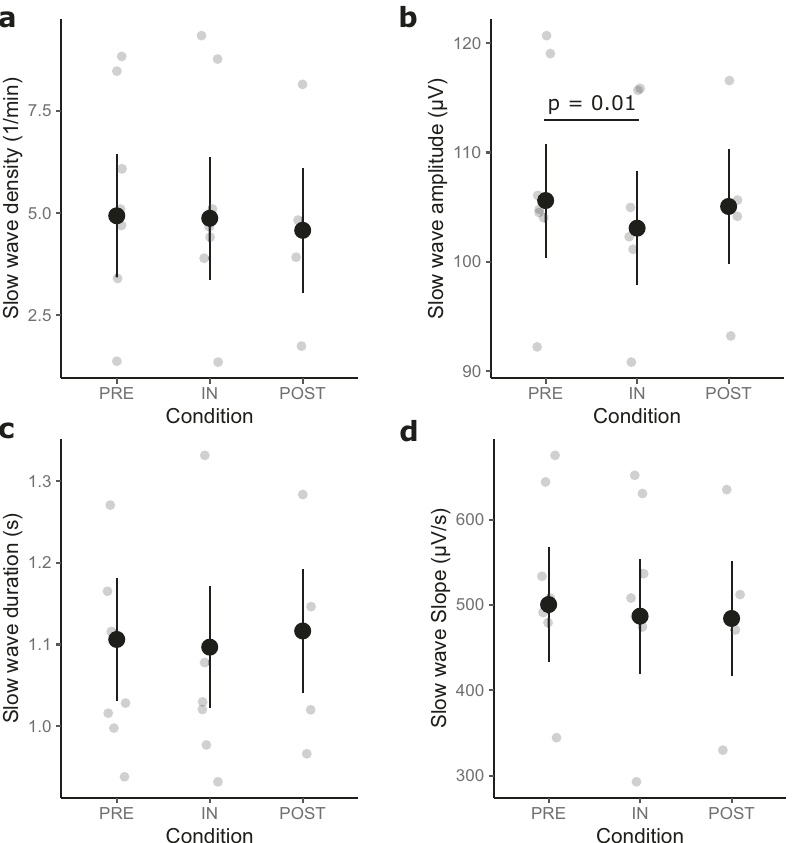
Fig. 5 Slow wave characteristics. Large dots represent the estimated marginal means (± standard error) of each condition. The smaller dots in the background are individual data points. Signi fi cant differences are indicated by a black bar with an annotation stating the p -value. a Shows the slow wave density. b Shows the slow wave amplitude which signi fi cantly differed in fl ight compared to pre fl ight. c Shows the slow wave duration. d Shows the slow wave